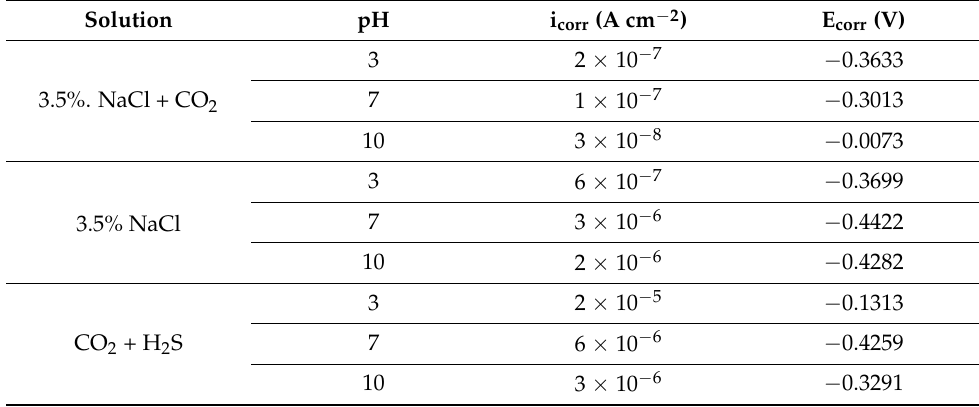
Figure 1. Potentiodynamic polarization plots with different pH values in ( a ) 3.5% NaCl + CO 2 , ( b ) 3.5% NaCl, and ( c ) CO 2 + H 2 S solutions. Table 1. Potentiodynamic polarization results in different solutions with different pH values.